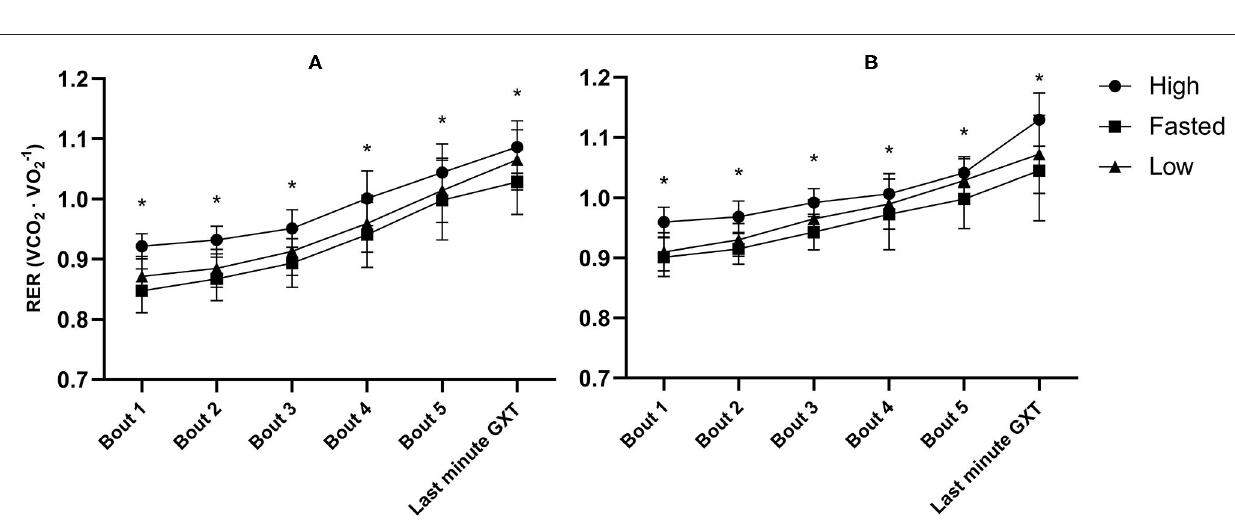
FIGURE 4 | Mean respiratory exchange ratio (RER) during the final minute of all five exercise bouts at ∼ 50, 60, 70, 80, and 90% of ˙ VO 2max and the graded exercise test (GXT) in well-trained (A) and recreationally trained (B) . High, pre-event meal with high carbohydrate content; low, pre-event meal with low carbohydrate content; fasted, test in fasted state. *significant effect of pre-event meals after a follow-up test with both groups included ( p ≤